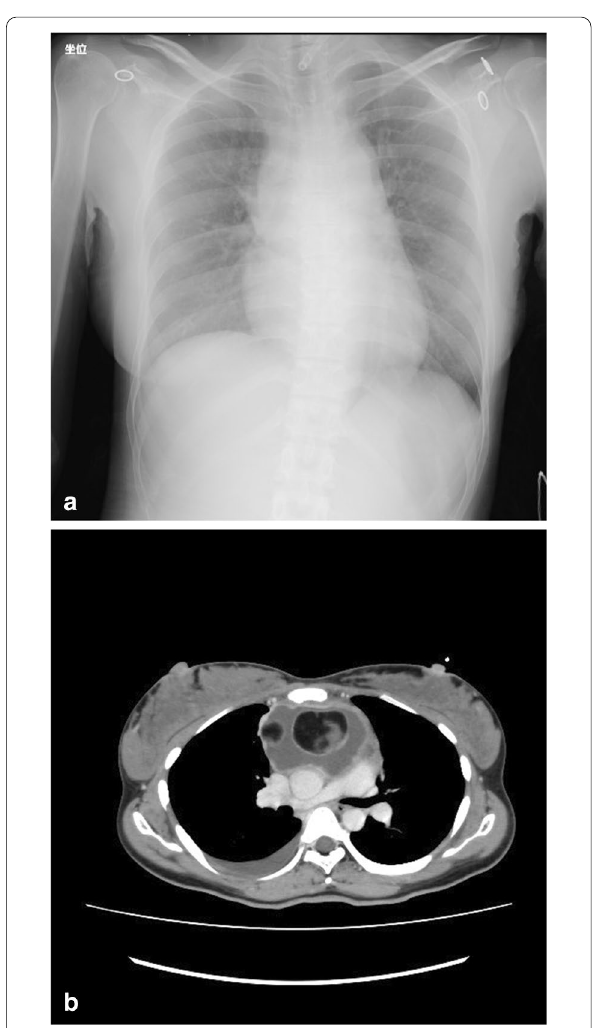
effusion in the right